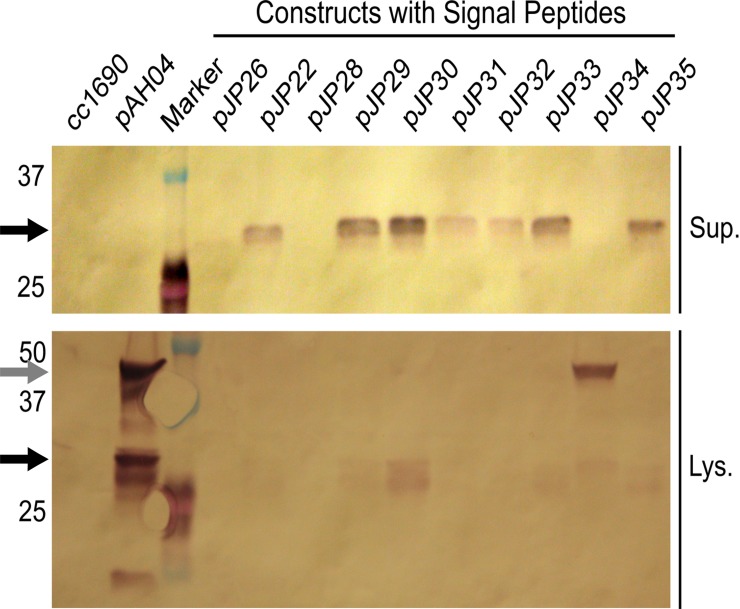
mCherry compartmentalization in immunoblotting analysis.Black arrow–mCherry bands, 27 KDa for unmodified and 29 KDa for post-translational modified; Grey arrow–mCherry band still fused with sh-ble and 2A autocleavage peptide, 46 KDa; Sup.–supernatant; Lys.–lysate, cc1690 –parental wild-type strain; pAH04 –construct without SP; pJP22 –construct with arylsulfatase 1 SP; pJP26 –construct with binding protein 1 SP; pJP28 –construct with carbonic anhydrase 1 SP; pJP29 –construct with ice-binding protein 1 SP; pJP30-35 –construct with in silico identified SP.